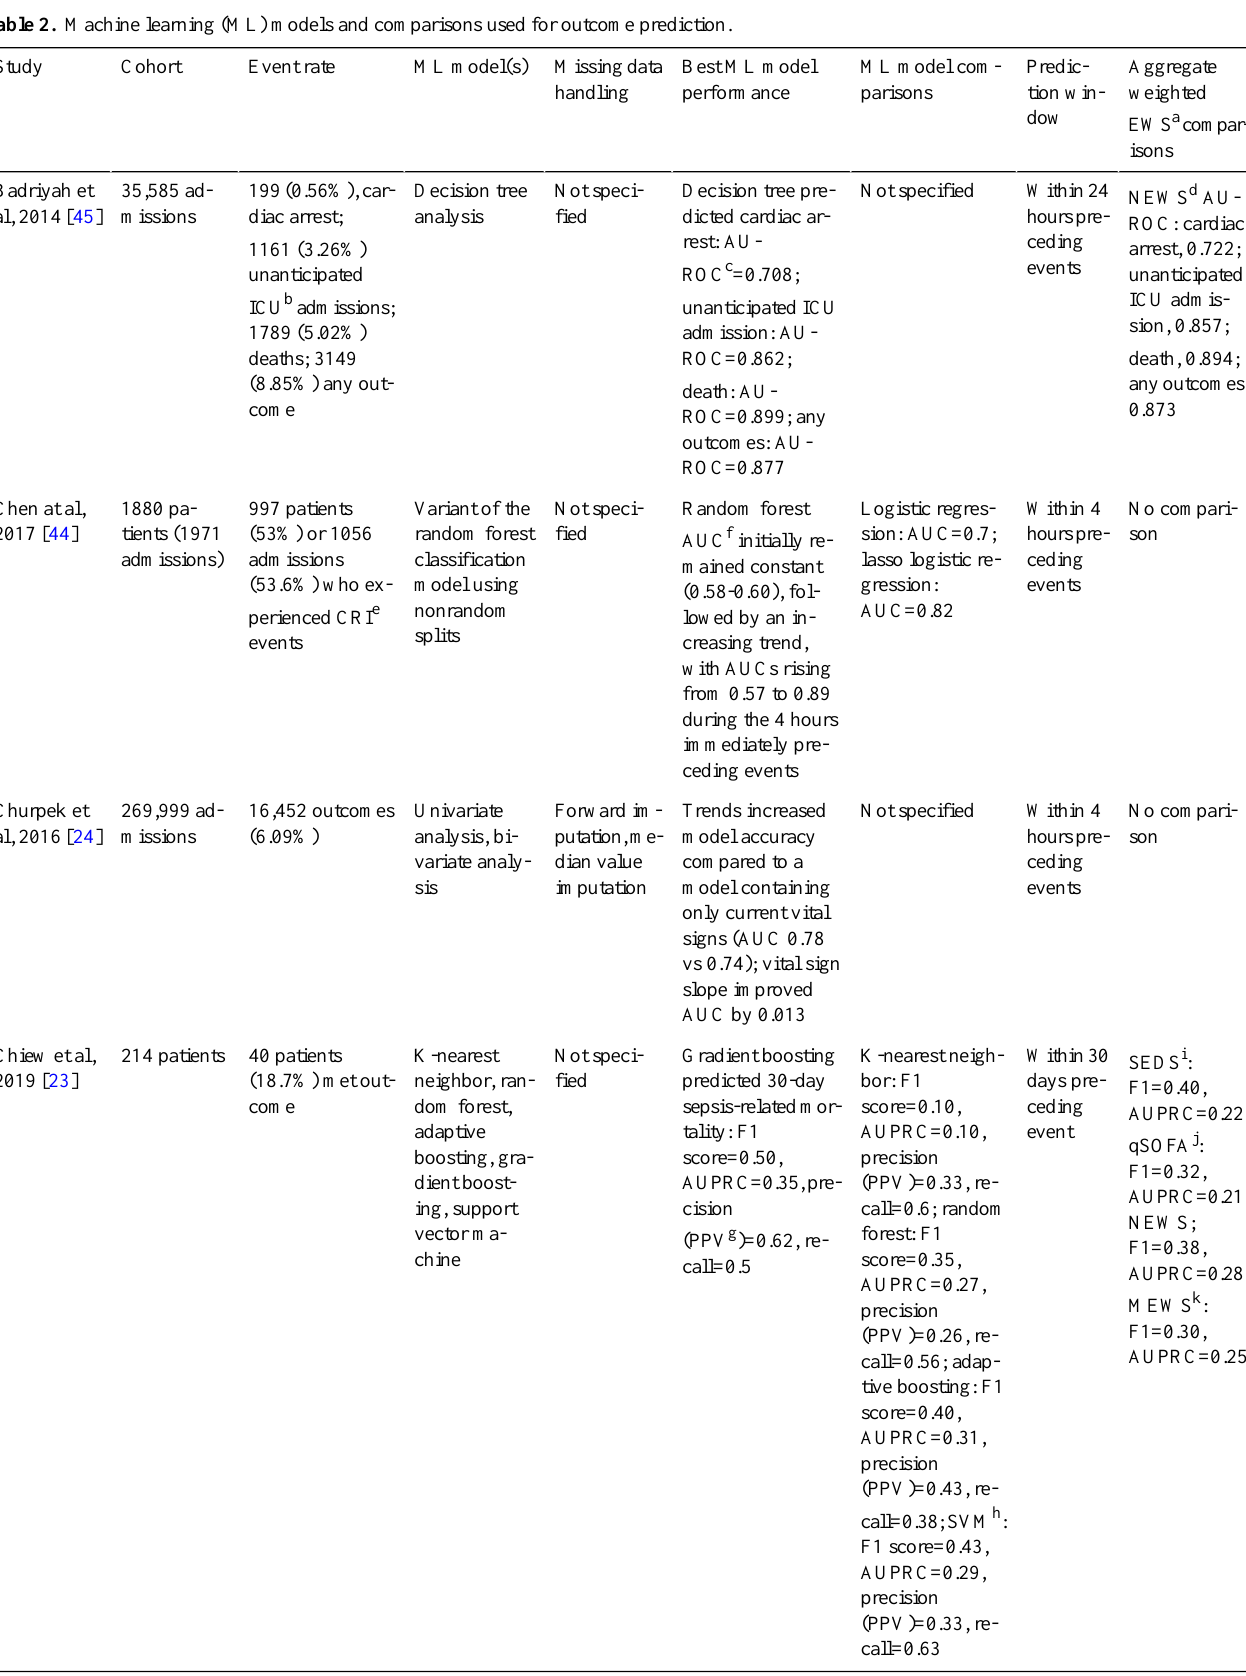
Table 2. Machine learning (ML) models and comparisons used for outcome prediction.